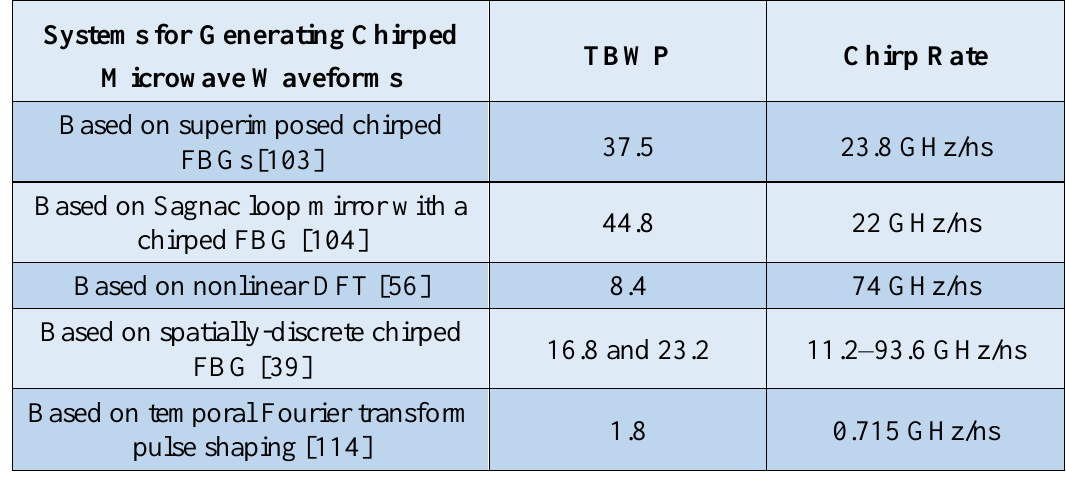
Table 1. Time-bandwidth product (TBWP) of chirped microwave waveforms that are generated by various all-fiber DFT-based microwave AWG